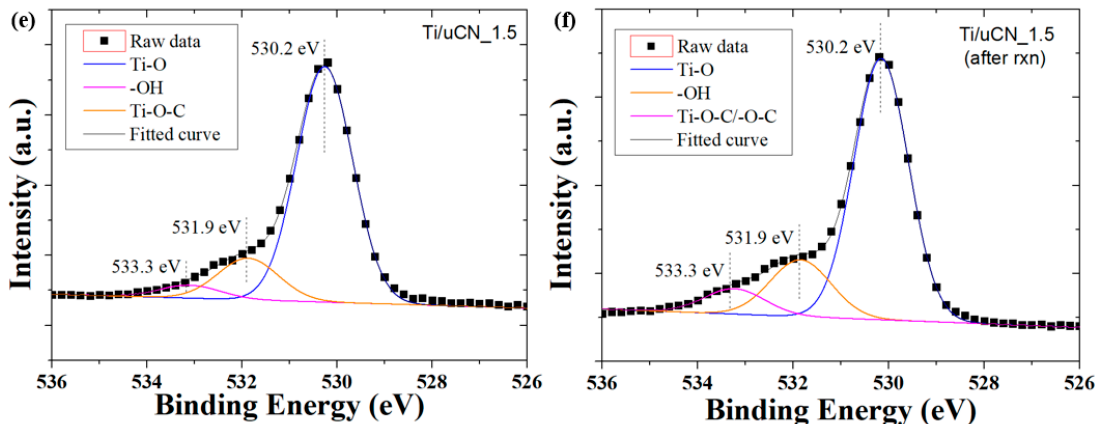
Figure 11. Deconvoluted XPS spectra in: ( a , b ) N1s; ( c , d ) C1s; and ( e , f ) O1s regions from Ti/uCN_1.5 ( a , c , e ) before and ( b , d , f ) after photoreduction.